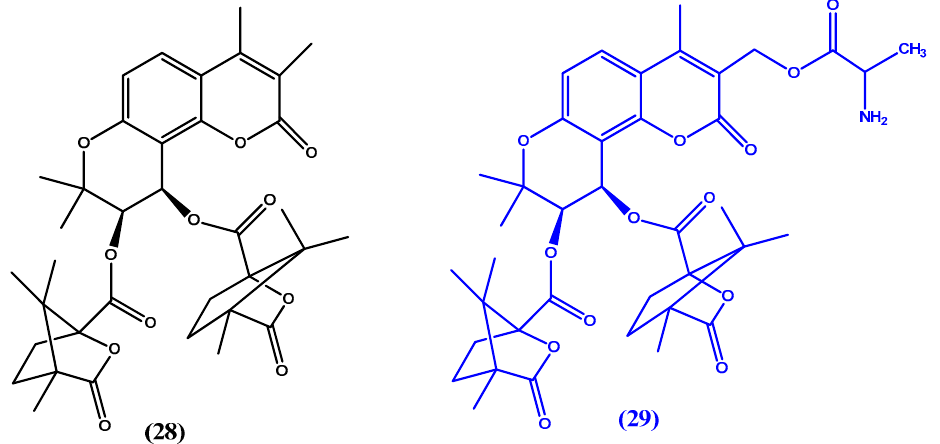
Figure 14. Chemical structures of 3 ′ ,4 ′ -di- O -(S)-camphanoyl-(+)- cis -khellactone (DCK) ( 28 ) and [3 ′ ,4 ′ -